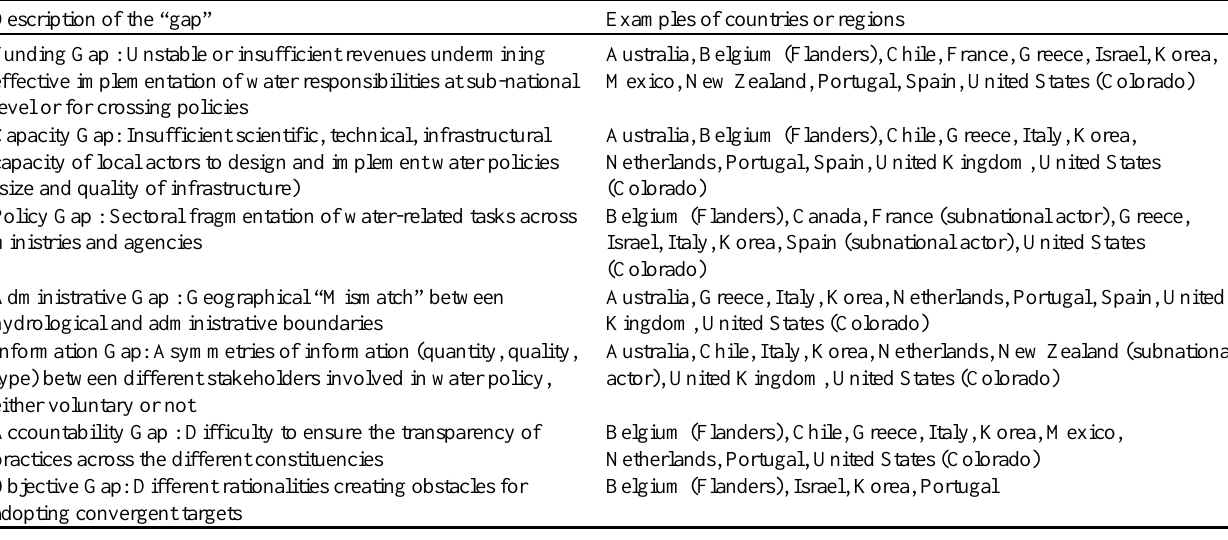
Table 1. Key multilevel governance challenges in OECD countries’ water policy making. Source: OECD Water Governance Survey (2010) Description of the